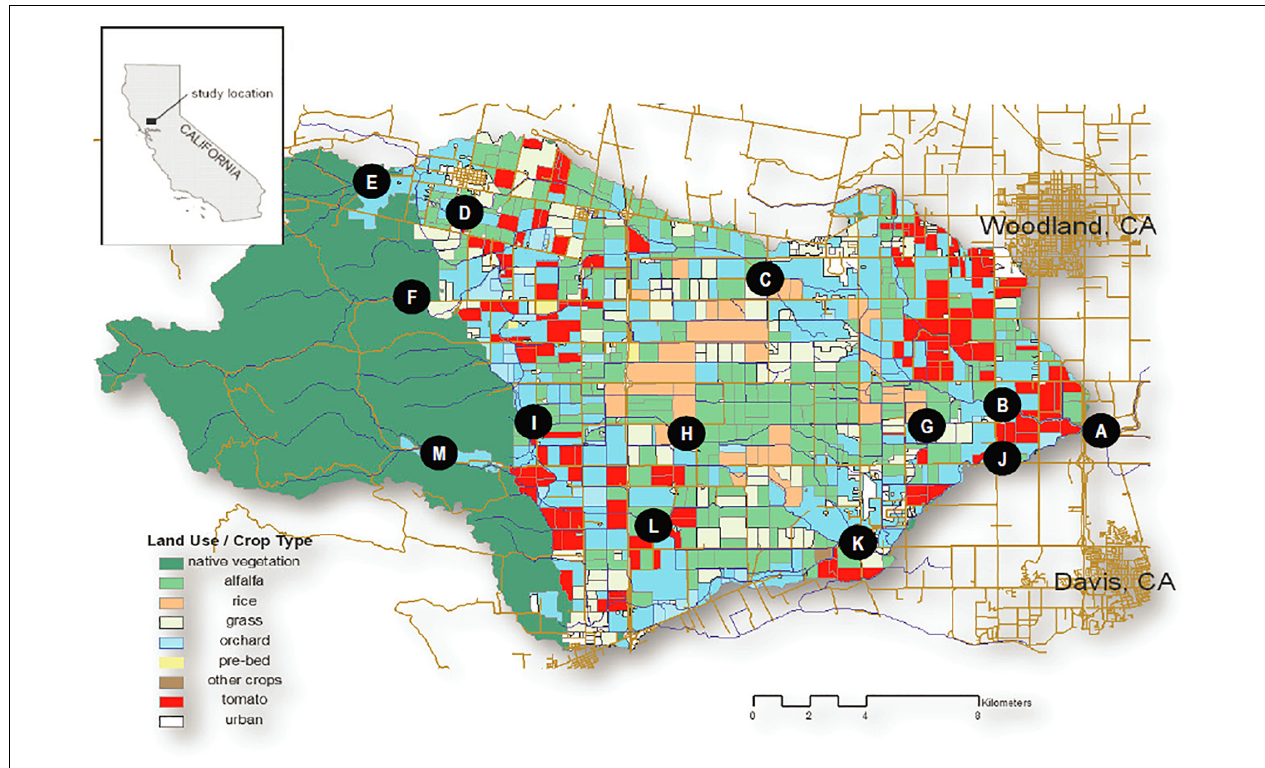
FIGURE 1 | Willow Slough Watershed and Sampling Sites by Subwatershed. Willow Slough Mainstem: (A) WS6 (Willow Slough mouth), (B) WS5, (C) WS3, (D) WS1, (E) PA0, (F) CO0. Union School Slough Subwatershed: (G) USS4, (H) USS2, (I) USS1. Chickahominy/Dry Slough Subwatershed: (J) CH4, (K) CH2, (L) CH1, (M) CH0. Note that sampling sites shown on the figure are referenced throughout the text in brackets, i.e.,